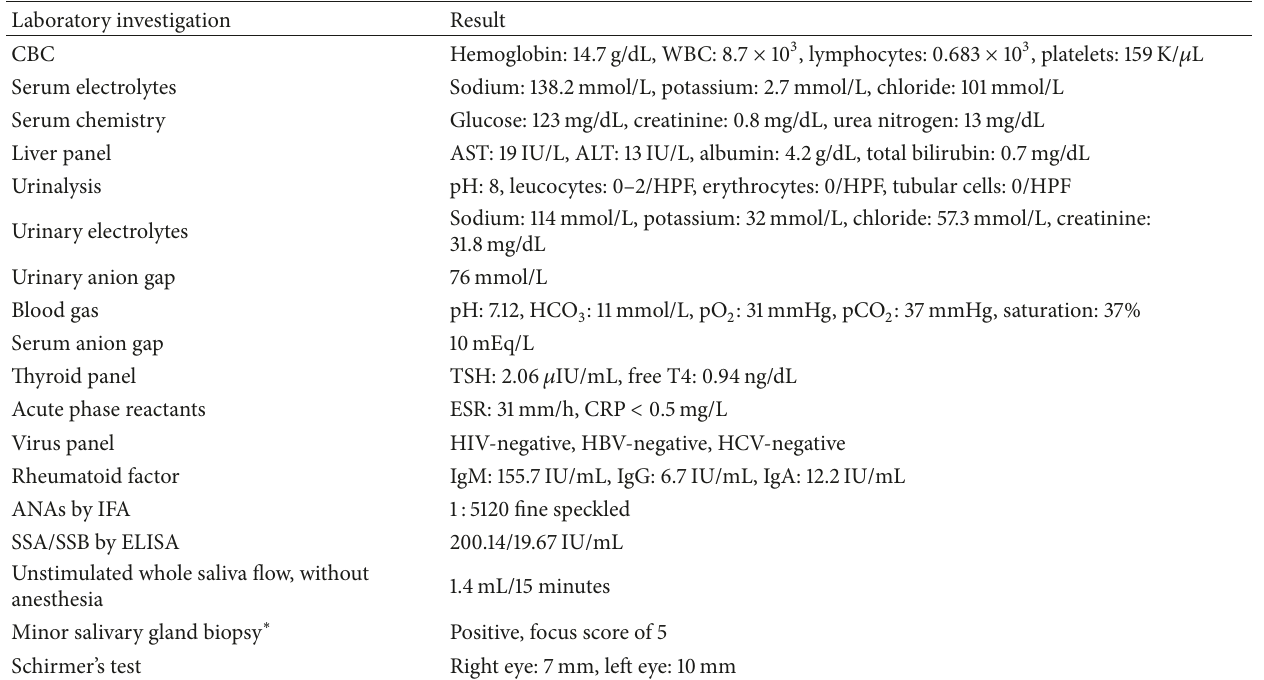
Table 1: Laboratory investigation.